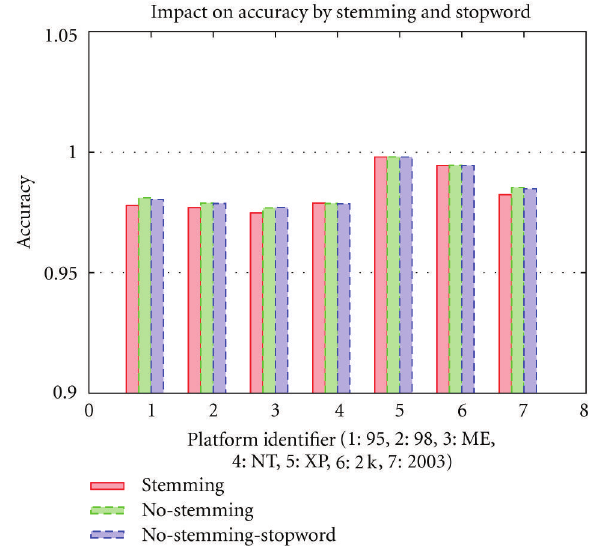
Figure 3: Accuracy on A ff ected Platform with/without stemming and stopword